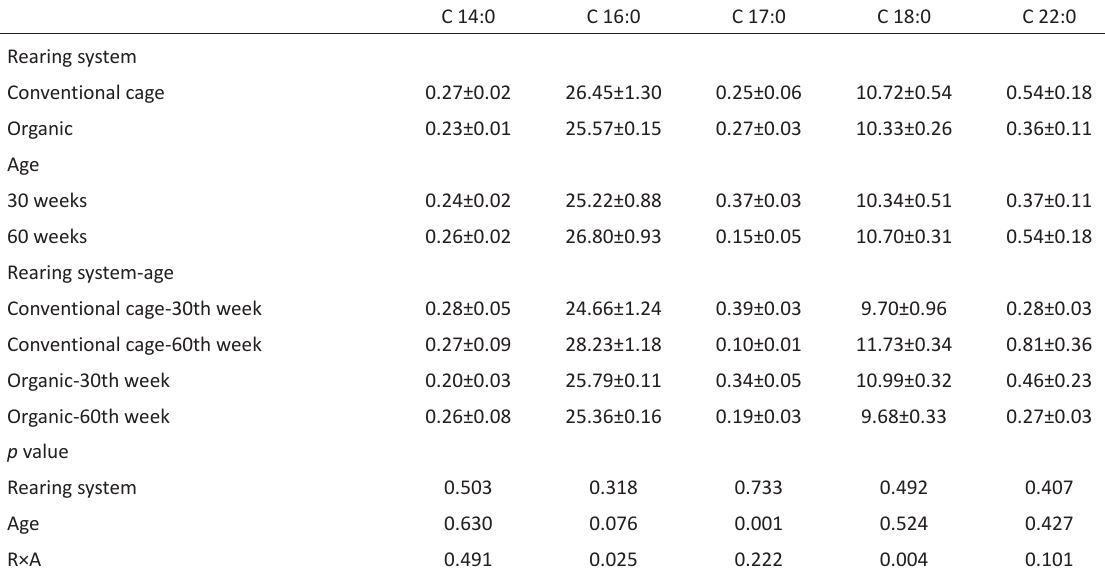
Table 4. Levels of saturated fatty acids in the egg yolks